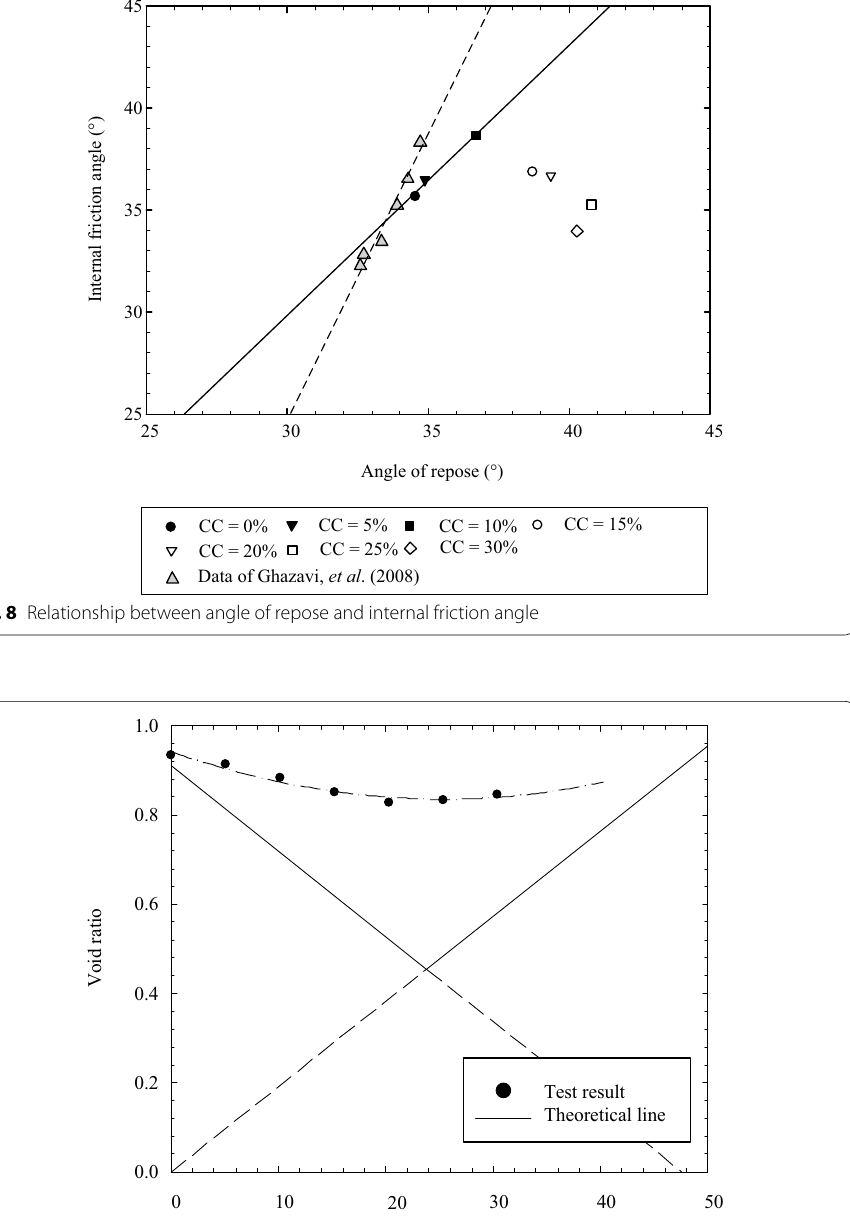
Clay content by volume